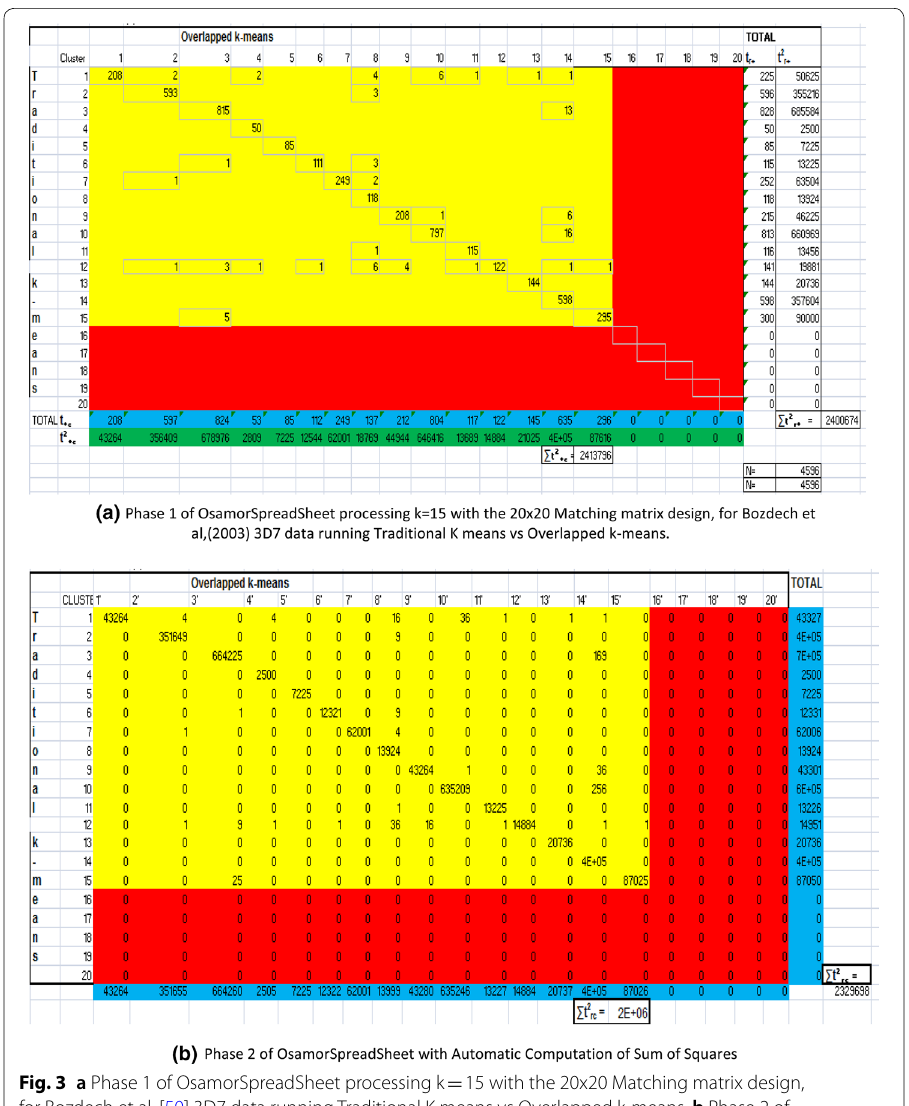
Fig. 3 a Phase 1 of OsamorSpreadSheet processing k 15 with the 20x20 Matching matrix design, = for Bozdech et al. [50] 3D7 data running Traditional K means vs Overlapped k-means. b Phase 2 of OsamorSpreadSheet with Automatic Computation of Sum of Squares. c Phase 3 of OsamorSpreadSheet completes the computation of other statistics required to display the ARI HA and the appropriate description of cluster validity according to our proposed